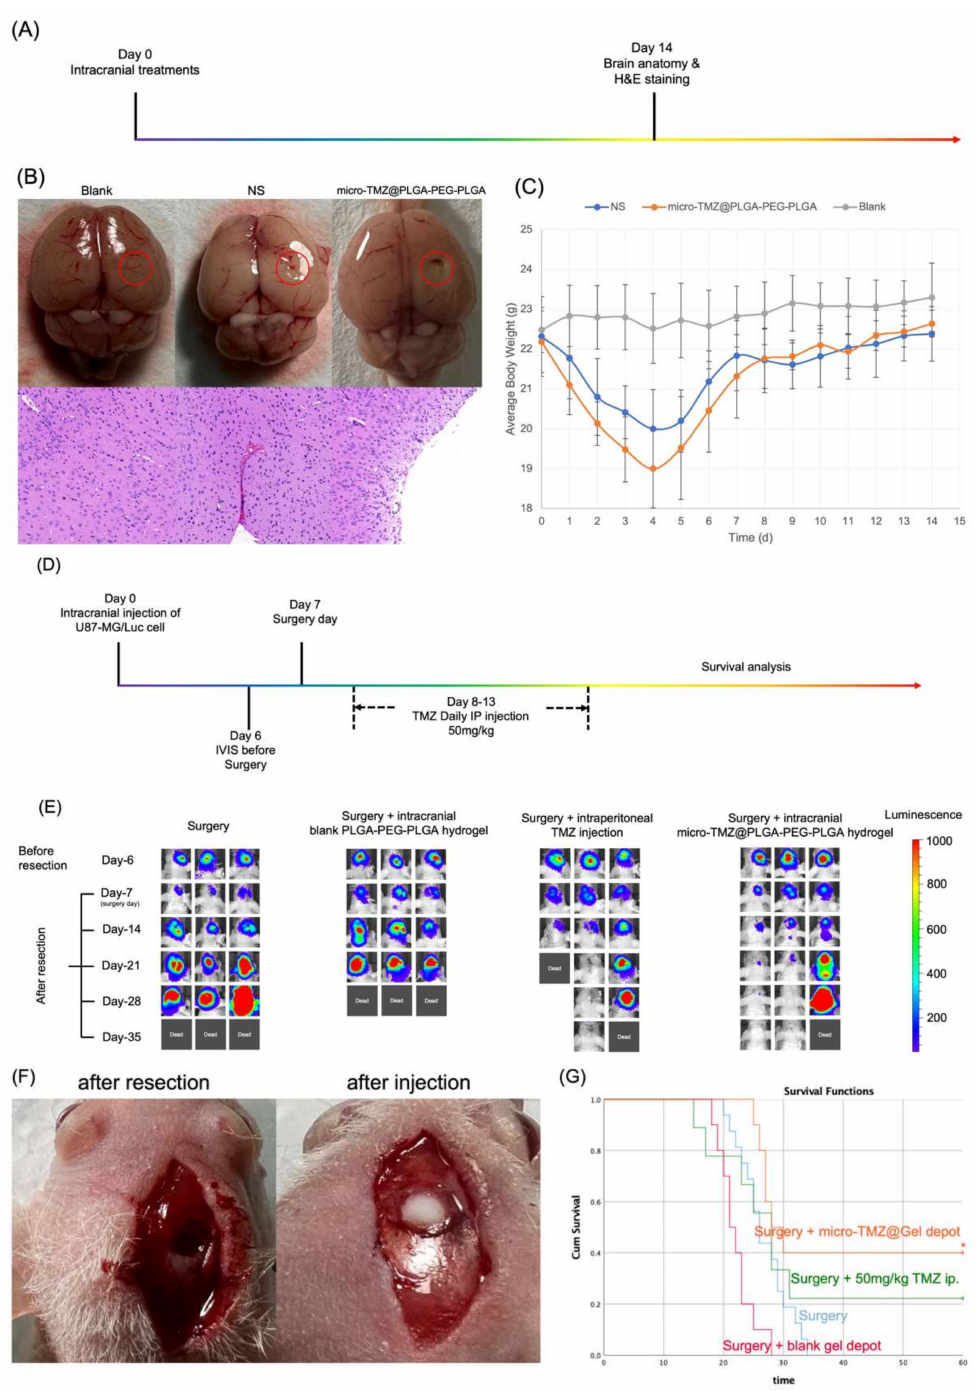
Figure 10. Safety and efficacy experiments of the micro-TMZ@PLGA–PEG–PLGA hydrogel. ( A ) Schedule of biosafety experiment of micro-TMZ@PLGA–PEG–PLGA hydrogel in vivo. ( B ) Macro appearance and H&E staining of healthy balb/c mice brain. ( C ) Bodyweight of balb/c mice under three different treatments (Blank group, NS group, micro-TMZ@PLGA–PEG–PLGA hydrogel group). ( D ) Schematic diagram of the anti-GBM experimental procedure. ( E ) Representative IVIS spectra of U87–MG/Luc cell in different treatment groups, n = 3. ( F ) In vivo image of balb/c nude mice after GBM tumor resection and micro-TMZ@PLGA–PEG–PLGA injection, respectively. ( G ) Survival curve of mice using Kaplan–Meier statistic survival analysis method. (n = 16 for surgery group, n = 10 for surgery + PLGA–PEG–PLGA group, n = 9 for surgery + TMZ intraperitoneal injection group, n = 10 for surgery + micro-TMZ@PLGA–PEG–PLGA group. *: p <